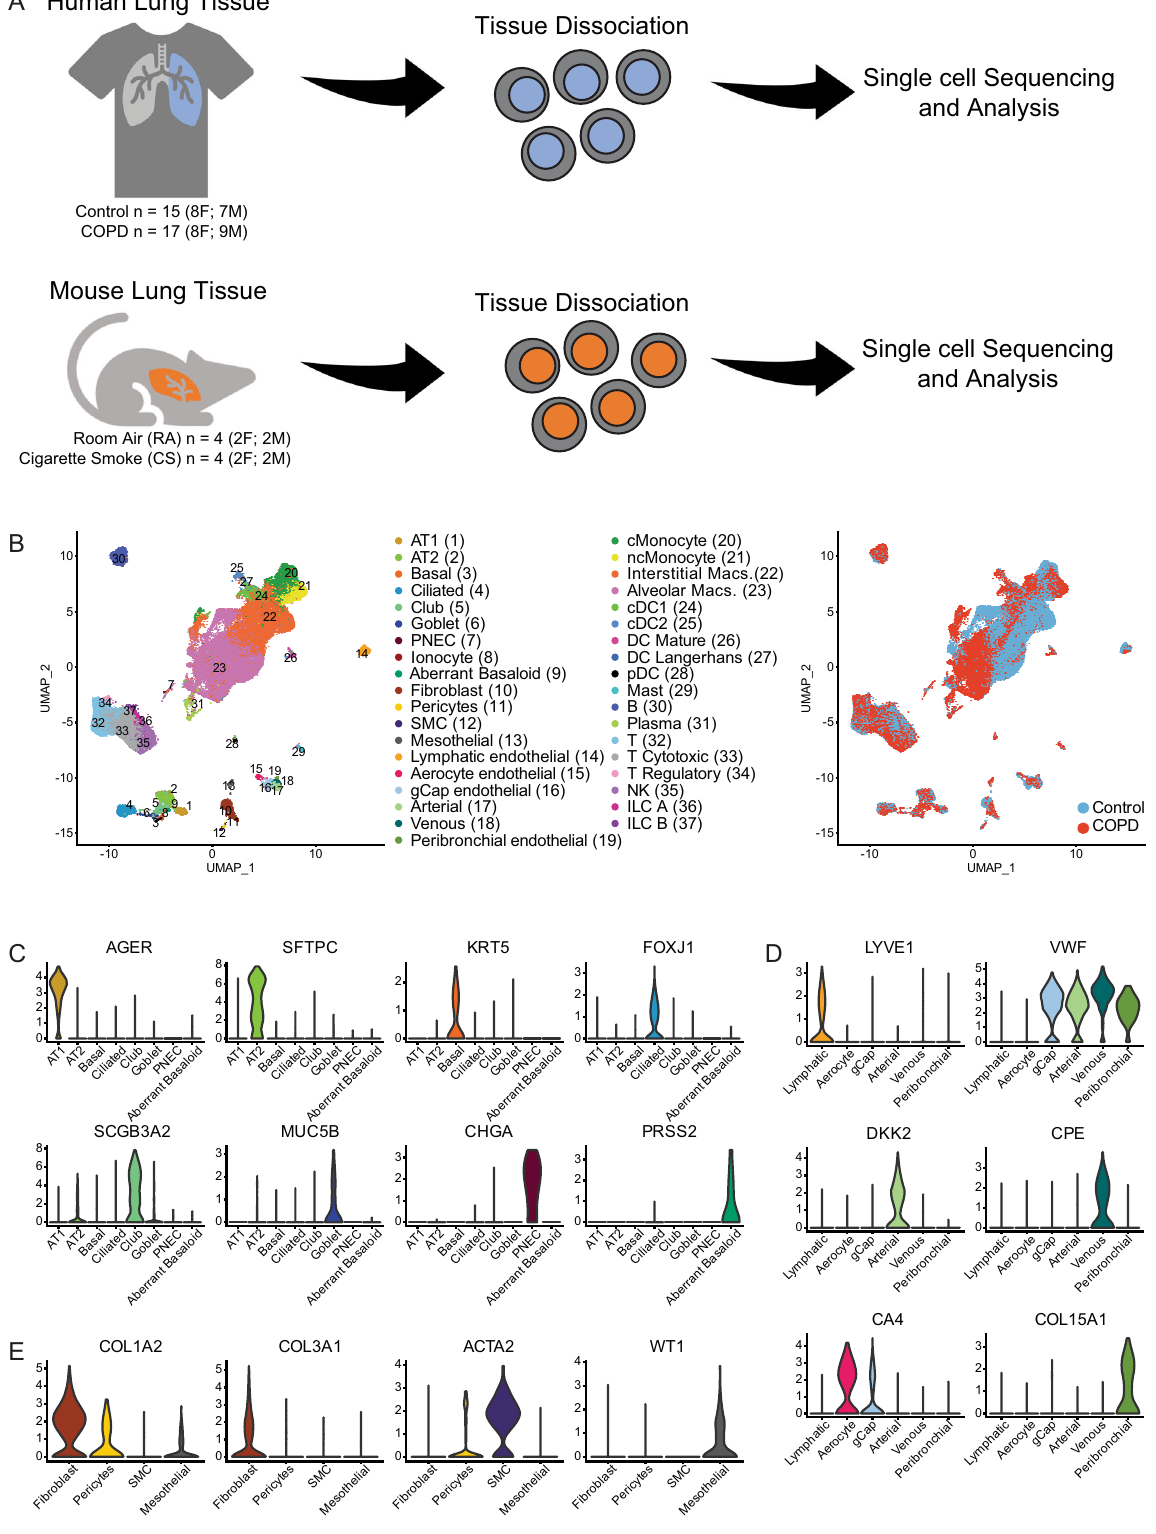
We observed 48% of SFTPC + cells contained HHIP foci and 79% of all HHIP foci colocalized with SFTPC + cells. We then assessed HHIP expression in isolated human AT2 epithelial cells obtained by fl uorescence-activated cell (FACS) sorting single-cell suspen- sions of human lung tissue samples (EpCAM high /PDPN − ) 15 .